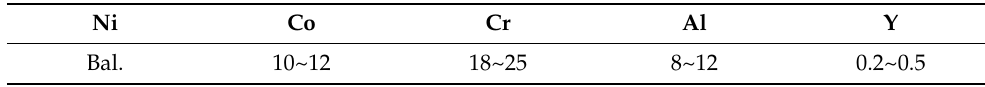
Table 1. Chemical composition (wt.%) of the bond